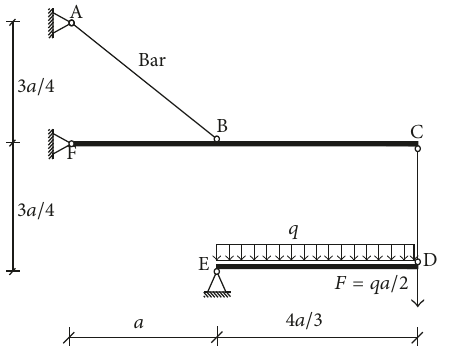
Figure 1: The steel bar structure with tensile performance function for Example 1.